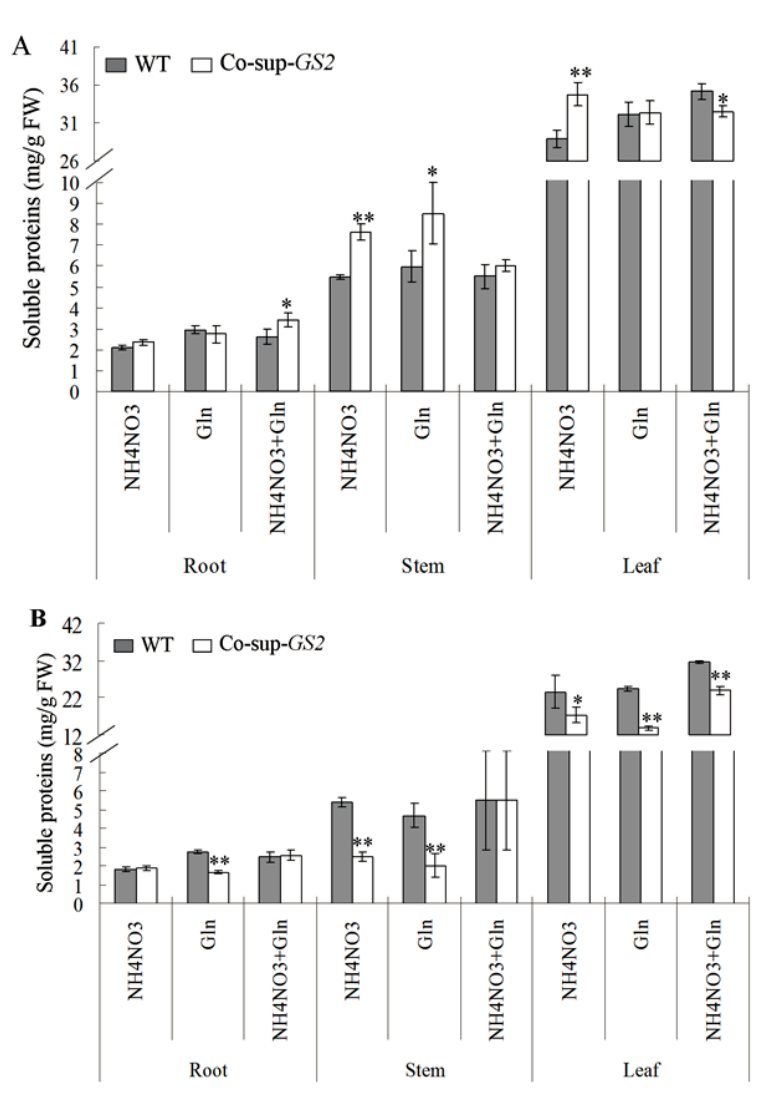
Figure 3. The concentration of soluble proteins in the roots, stems and uppermost leaves of GS2 -cosuppressed plants (Co-sup- GS2 ) and wild-type plants (WT) at the seedling stage ( A ) and the tillering stage ( B ) under N (NH 4 NO 3 ), G (Gln) and N + G (NH 4 NO 3 + Gln) conditions. Values are the mean ± SD from three biological replicated plant materials. *, ** Significant differences at the level of p = 0.05 and p = 0.01,